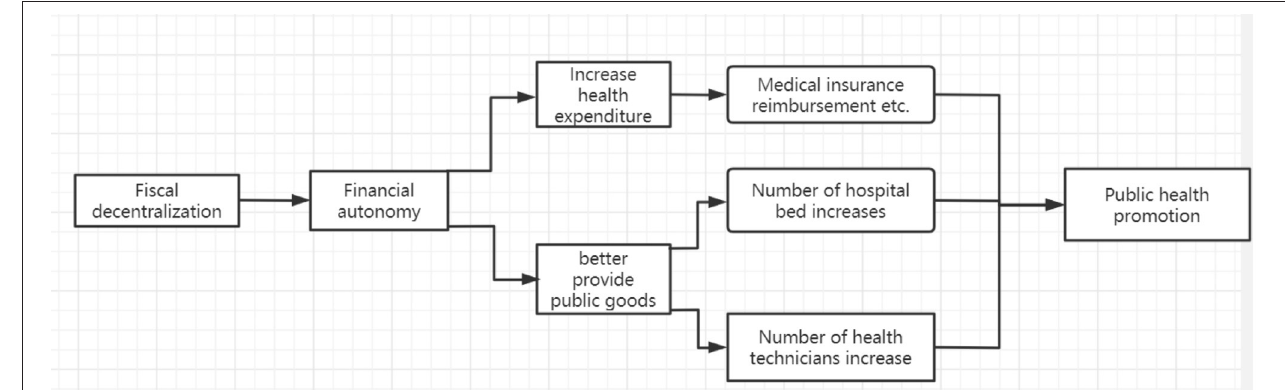
FIGURE 4 | Mechanism flow chart.